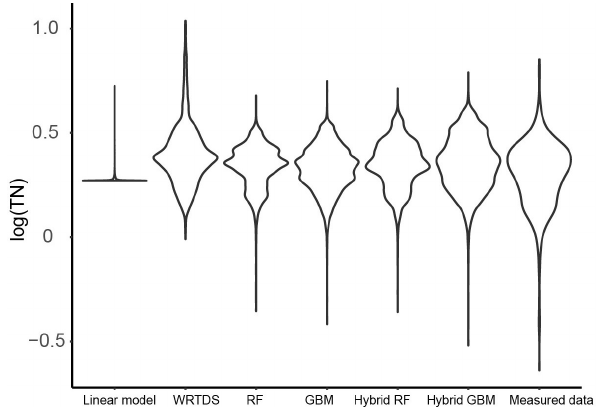
Figure 5. The distribution of the daily TN generated by the six mod- els and that of the measured TN data in Ellen